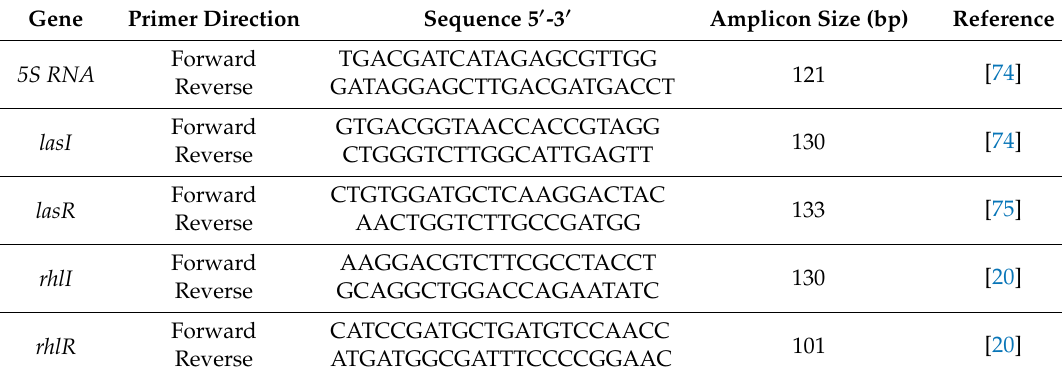
Table 5. List of primer sequences used for quantitative Real-time PCR (qRT-PCR). Gene Primer Direction Sequence 5 (cid:48) -3 (cid:48) Amplicon Size (bp) Reference 5S RNA